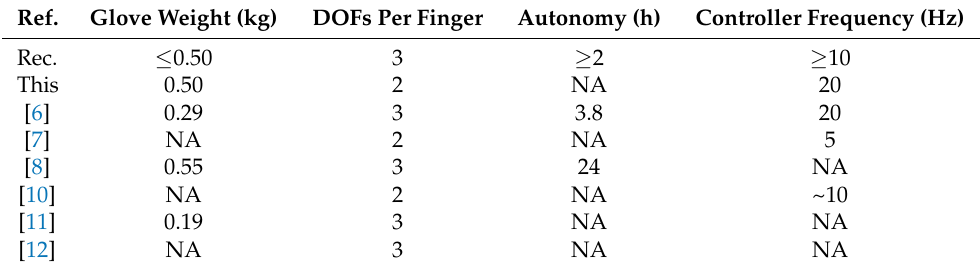
Table 2. Requirements of robotic gloves (adapted from [6]). NA: not available. Ref. Glove Weight (kg) DOFs Per Finger Autonomy (h) Controller Frequency (Hz) Rec. ≤ 0.50 3 ≥ 2 ≥ 10 This 0.50 2 NA 20 [6] 0.29 3 3.8 20 [7] NA 2